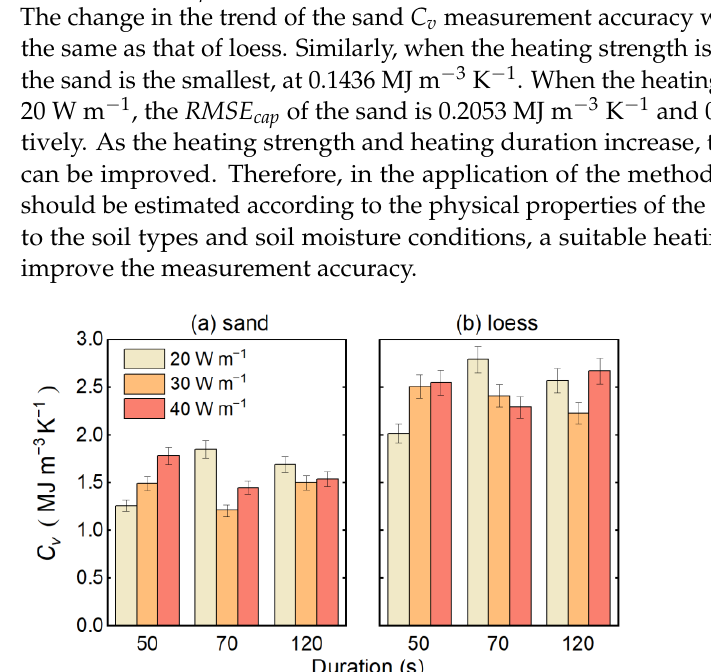
Figure 6. Measurement results of the C v of the sand ( a ) and loess ( b ) under different heating strategies.